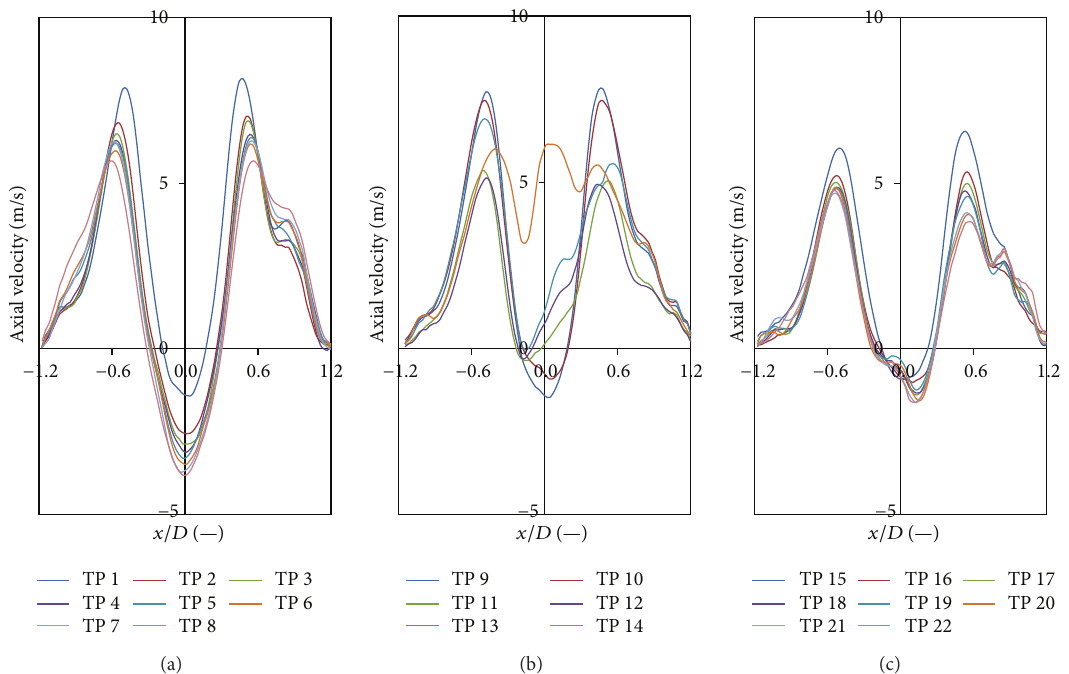
Figure 8: Axial velocities at 𝑦/𝐷 = 0.5 for test points detailed in Table 1 with the diffusive injection of (a) methane, (b) air, and (c) carbon